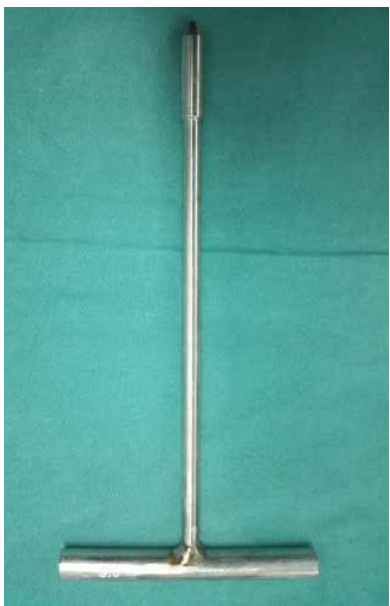
Figure 2: The Dilator. The dilator consists of a distal tapered tip mounted on the distal end of a shaft, a cylindrical shaft and a